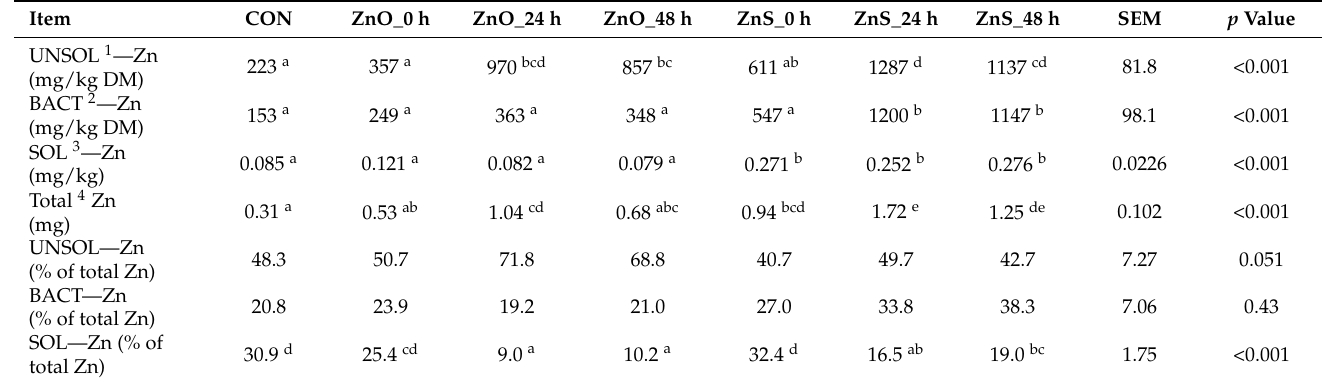
Table 6. Influence of inorganic Zn source and addition time on solubility